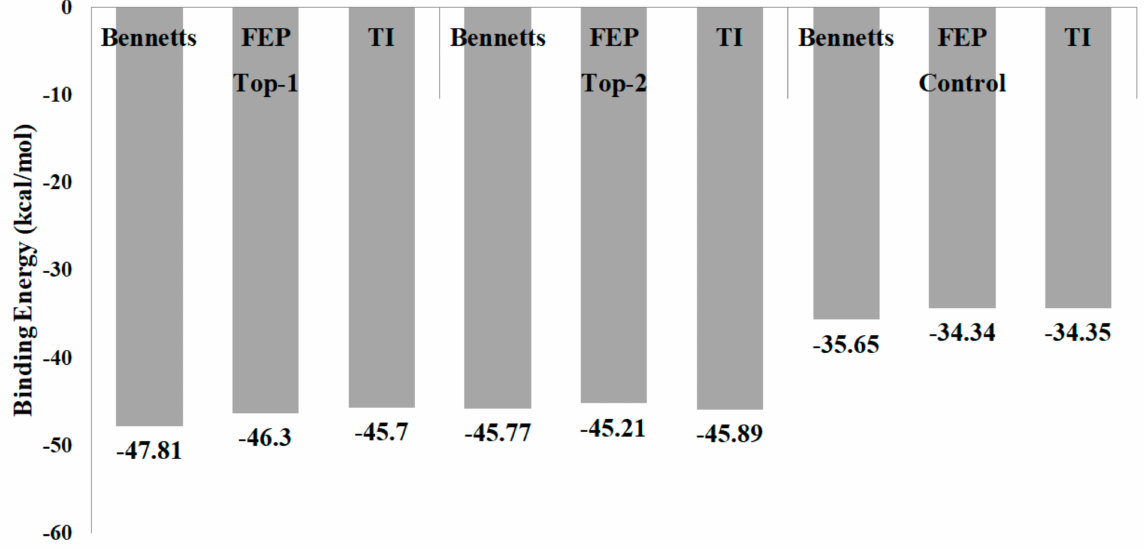
Figure 6. Binding energy values (kcal/mol) calculated by different methods in